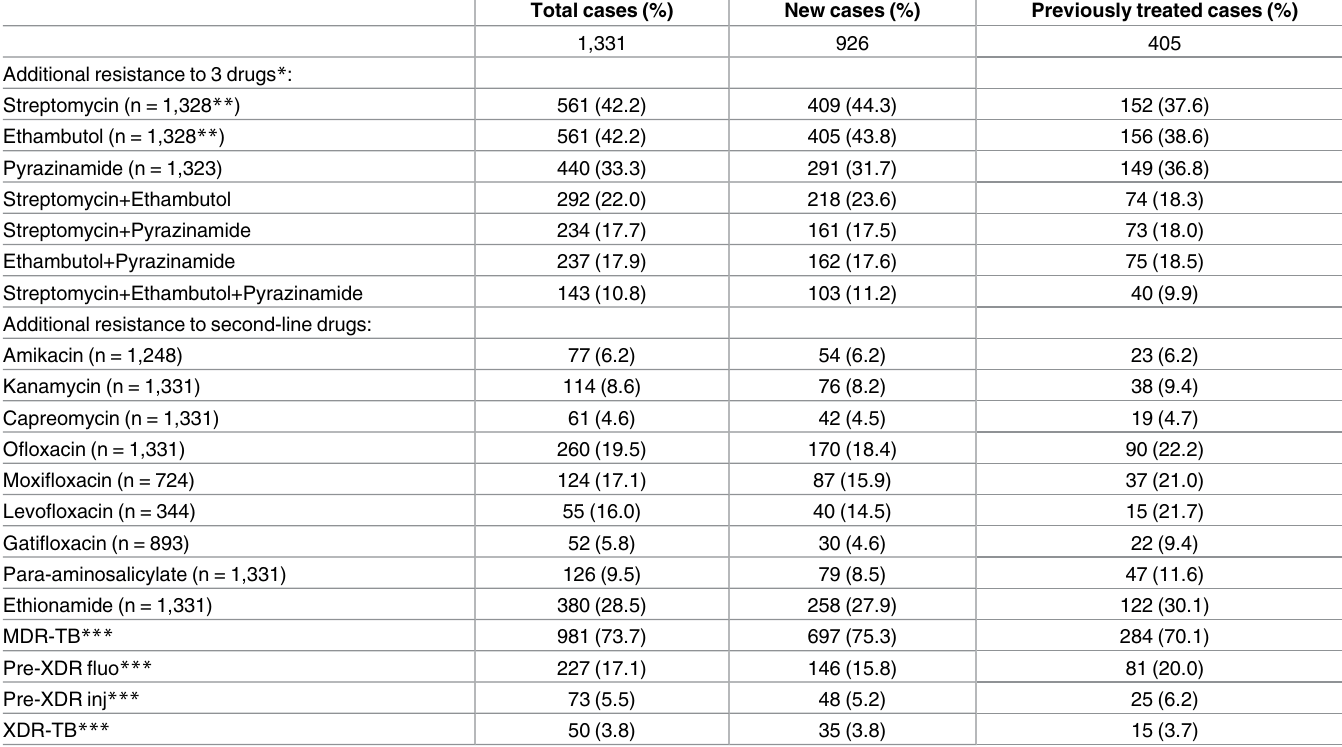
Table 2. Drug resistance prevalence of MDR-TB cases in Taiwan, 2007–2014.